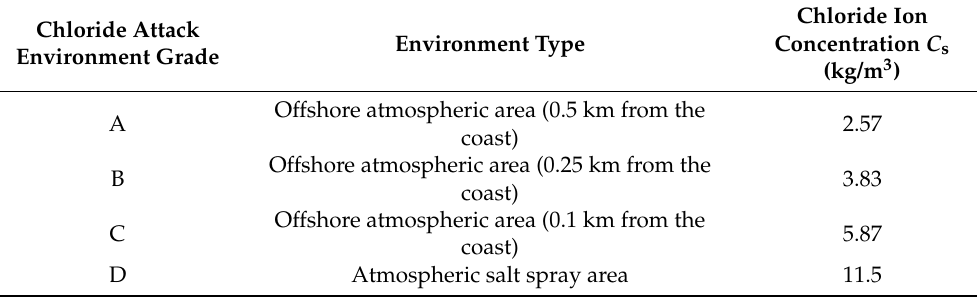
Table 5. Chloride attack environment